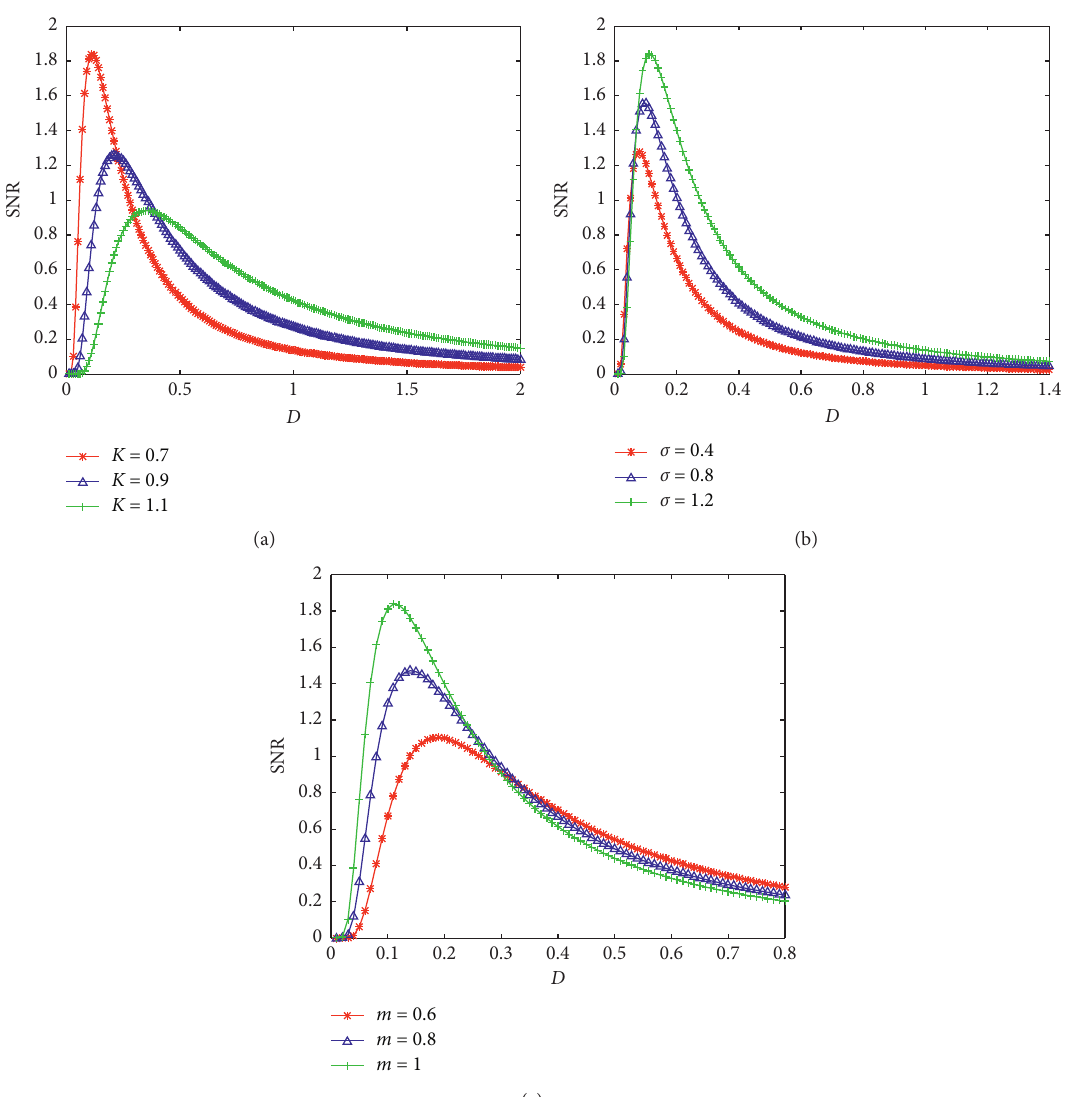
Figure 3: The change trends of SNR versus D: (a) m � 1 and σ � 1.2; (b) m � 1 and K � 0.7; (c) K � 0.7 and σ �